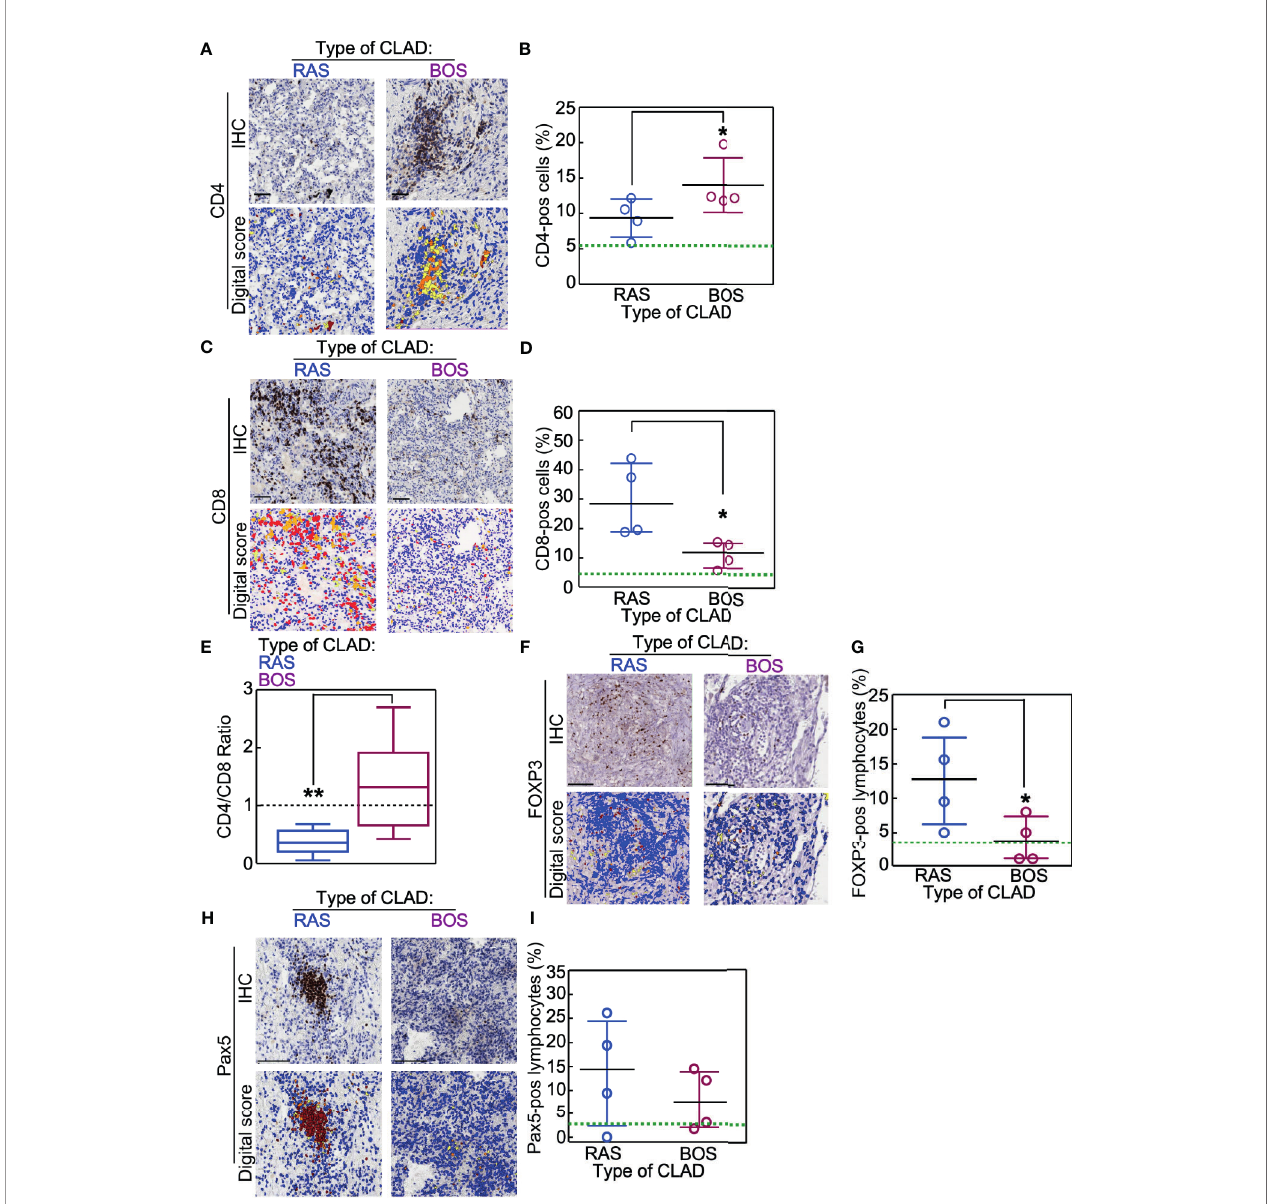
FIGURE 1 | Immunophenotype of lungs explanted for re-transplantation (re-LTx). Lymphocyte subsets were analyzed in BOS and RAS re-LTx (n = 4 cases per condition). (A – D) CD4 pos (A, B) and CD8 pos (C, D) T lymphocytes were identi fi ed and scored as the percentage of positive cells in that area using Aperio algorithm (digital score mask). Each dot is a case, and lines indicate median with IQR. *p = 0.02 by Mann-Whitney U test. (E) The CD4/CD8 ratio was calculated for RAS and BOS re-LTx. Data are expressed as box-plot with whiskers indicating min to max values. **p = 0.003 by two-sided Mann-Whitney U test. (F – I) Foxp3-positive (F, G) or Pax5-positive (B cells; H, I ) lymphocytes were identi fi ed and scored in RAS or BOS lungs. Each dot is a case, and lines indicate median with IQR. *p = 0.03 by Mann-Whitney U test. Scale bars, 100 m m. Green lines within graphs indicate the mean value of the marker measured in normal lungs (see also Supplementary Figure 3 for